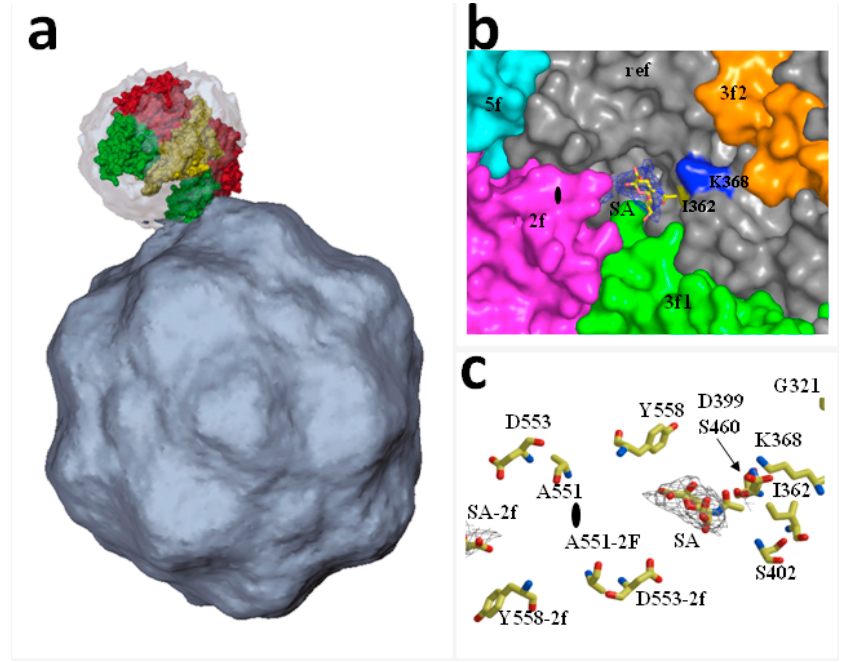
Figure 1. Structures of receptor-Protoparvovirus capsid complexes: ( a ) Asymmetric binding of transferrin receptor (TfR) to the CPV capsid. The image illustrates a TfR dimer manually fitted into the cryoEM density of CPV capsid. The interaction is best resolved between one of the two apical domains of the TfR dimer (green) and the shoulder of a spike near a three-fold icosahedral axis of the CPV capsid. (Reproduced with permission from Hafenstein, S. et al. [32]); ( b , c ) X-ray crystal structure identifying an infectious receptor attachment site on a PtPV capsid at high resolution: MVMp capsids soaked with sialic acid showing the electron density of the carbon backbone allocated in the twofold pocket adjacent to the I362 and K368 residues determining in vivo pathogenicity in severely combined immunodeficient (scid) mice. (Reproduced with ASM permission from Lopez-Bueno et al. [33]). Sialic acid (SA; N -acetylneuraminic acid) glycan isanother well-characterized PtPV receptor, which is probably the most commonly used in